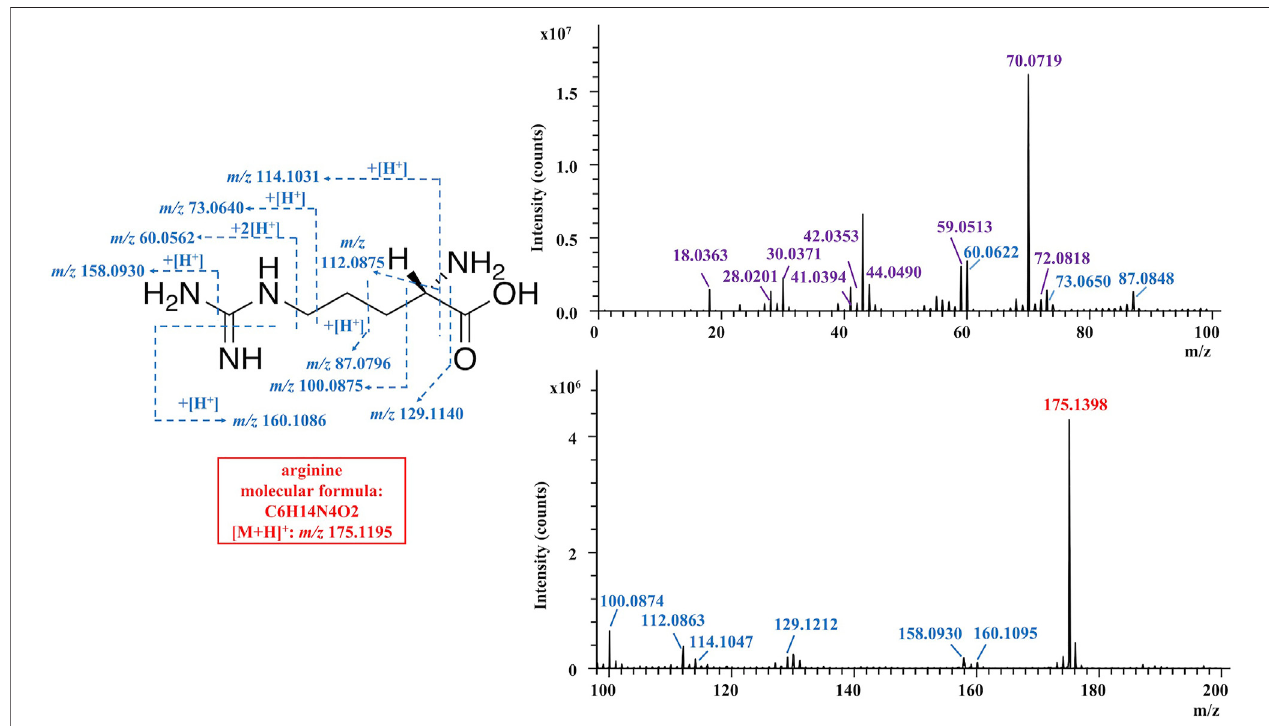
FIGURE 2 | TOF-SIMS spectra of arginine standard in the positive mode.